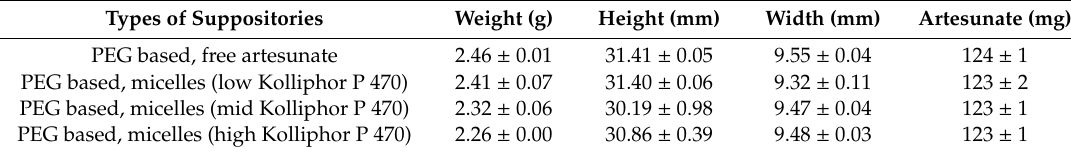
Table 1. Physical properties of polyethylene glycol (PEG)-based suppositories carrying artesunate.